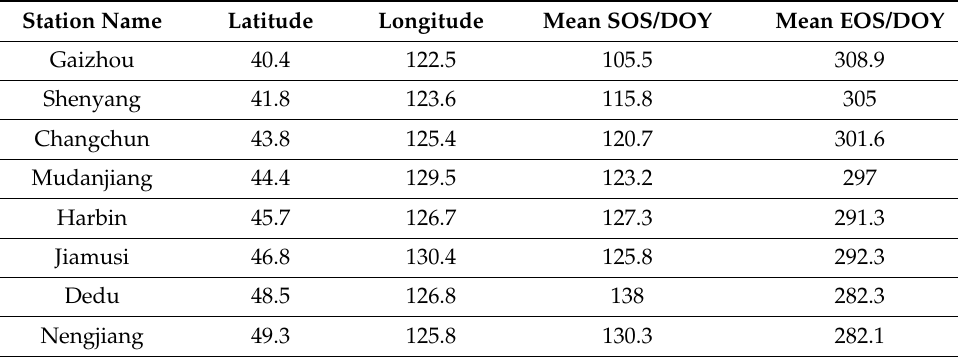
Table 2. The mean forest phenological parameters of each station over the years.